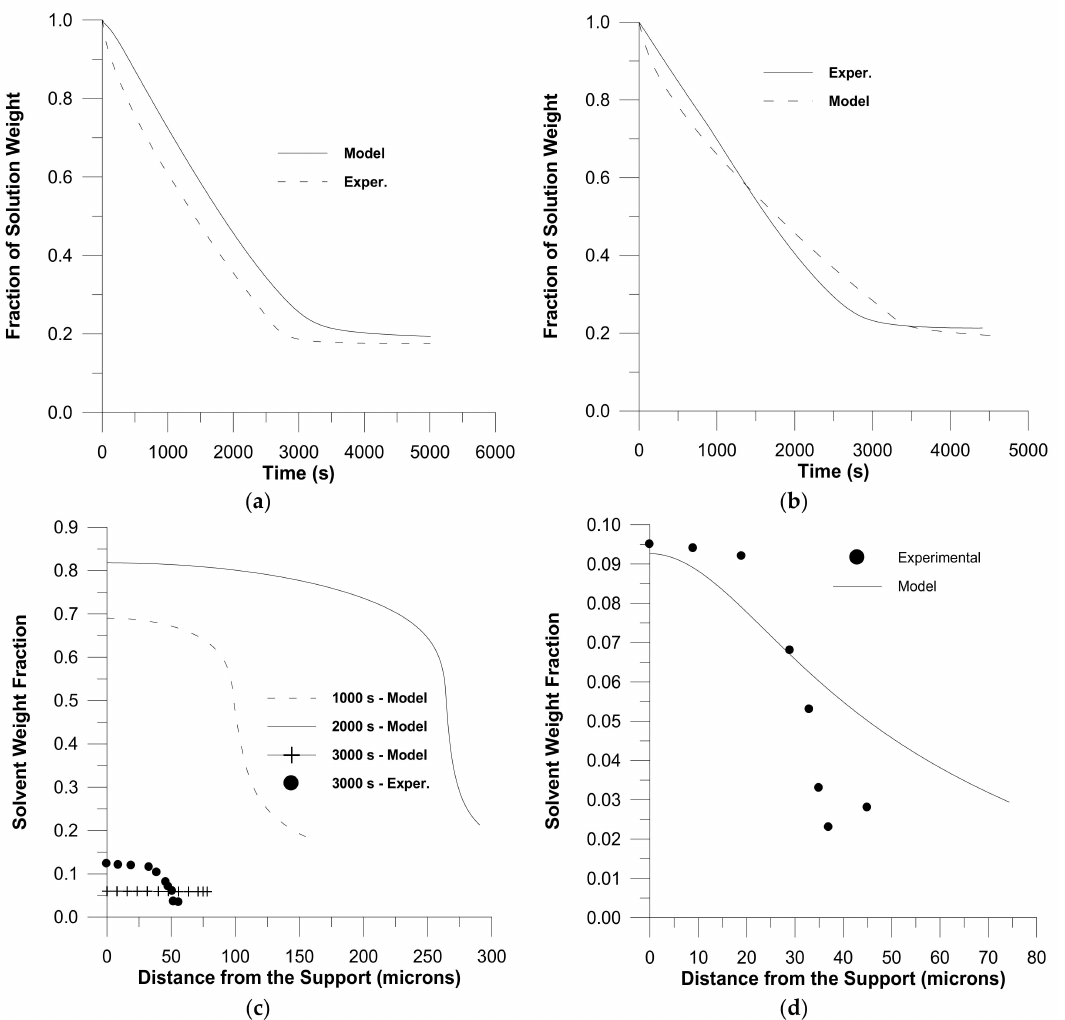
Figure 5. Non-Fickian diffusion for the system poly(styrene)/p-xylene (used with copyright permission) [37]. ( a ) Fraction of solution weight as a function of evaporation time. Initial p-xylene weight fraction: 0.84, drying air = 302 K, initial coating thickness = 0.487 mm. ( b ) Fraction of solution weight as a function of evaporation time. Initial p-xylene weight fraction: 0.84, drying air = 302 K, initial coating thickness = 0.466 mm. ( c ) Solvent weight fraction profiles. Initial p-xylene weight fraction: 0.84, drying air = 302 K, initial coating thickness = 0.487 mm. ( d ) Solvent weight fraction profiles. Initial p-xylene weight fraction: 0.84, drying air = 302 K, initial coating thickness = 0.466